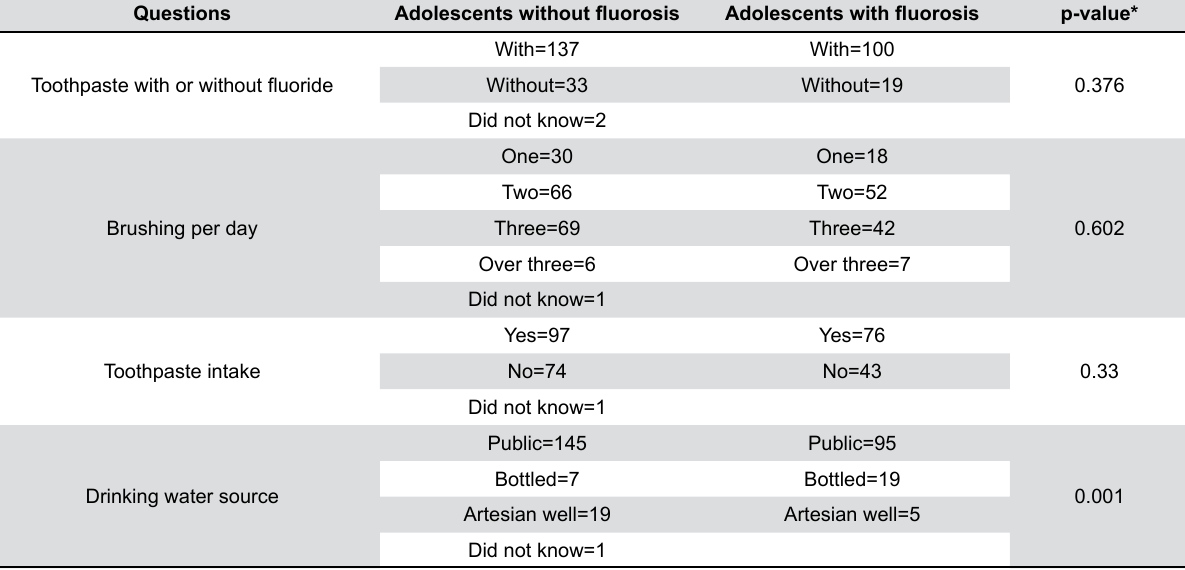
Toothpaste with or without fluoride